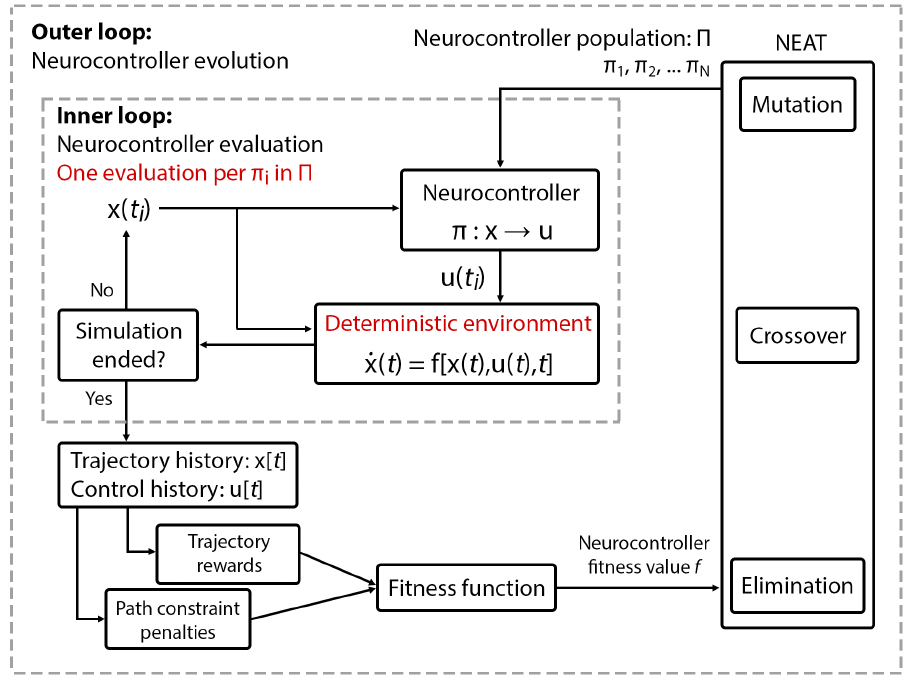
Figure 6. Neurocontroller evolution